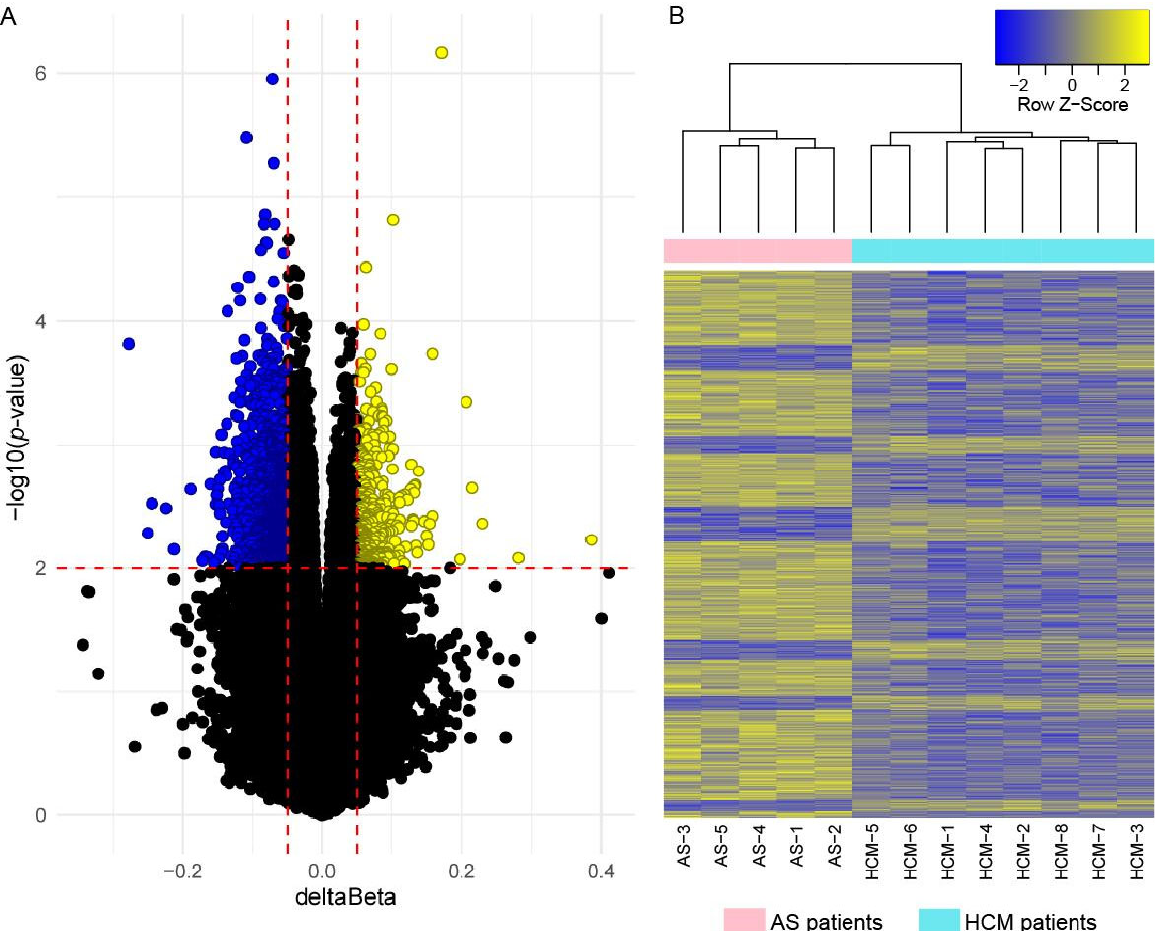
Figure 2. Visualization of the DMPs identified in LV myocardial tissue of HCM patients when compared to AS patients. ( A ): Volcano plot of all CpG site methylation levels. Red vertical lines indicate threshold for methylation differences (|deltaBeta| = 0.05); red horizontal line—threshold for statistical significance ( p = 0.01). DMPs passing both thresholds are marked on the figure with blue dots (hypomethylated in HCM) and yellow dots (hypermethylated in HCM). ( B ): Heatmap of z-scored methylation levels of 1755 identified DMPs in all studied patients. Methylation level varies from fully unmethylated (blue) to fully methylated (yellow). Top dendrogram shows hierarchical clustering of DNA samples. Cyan indicates DNA samples from HCM patients; pink—from AS patients.